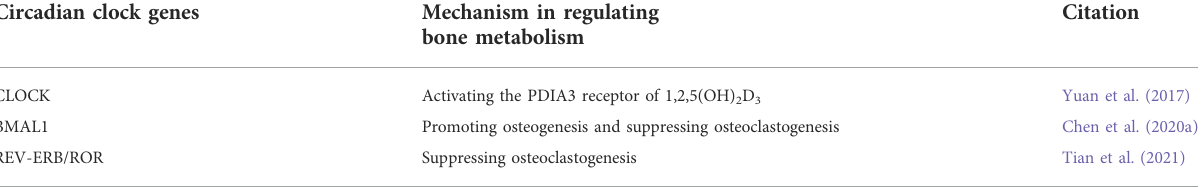
TABLE 2 Circadian clock genes and mechanism regulated by melatonin in bone